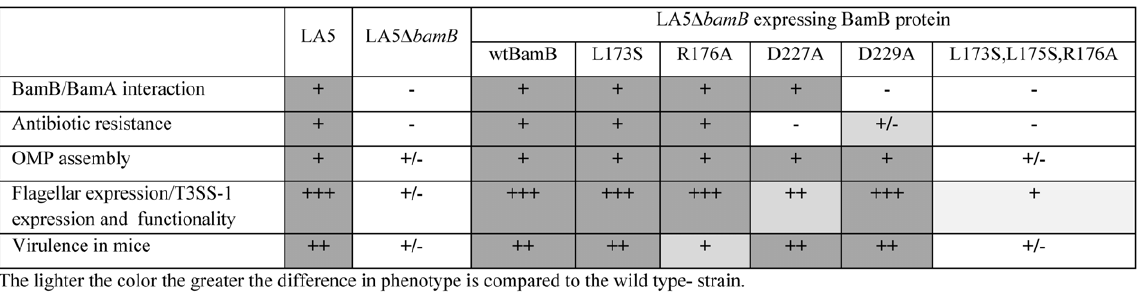
Figure 5. Overview of phenotypic traits of S. Enteritidis LA5 D bamB mutant strains expressing BamB proteins with point mutations.